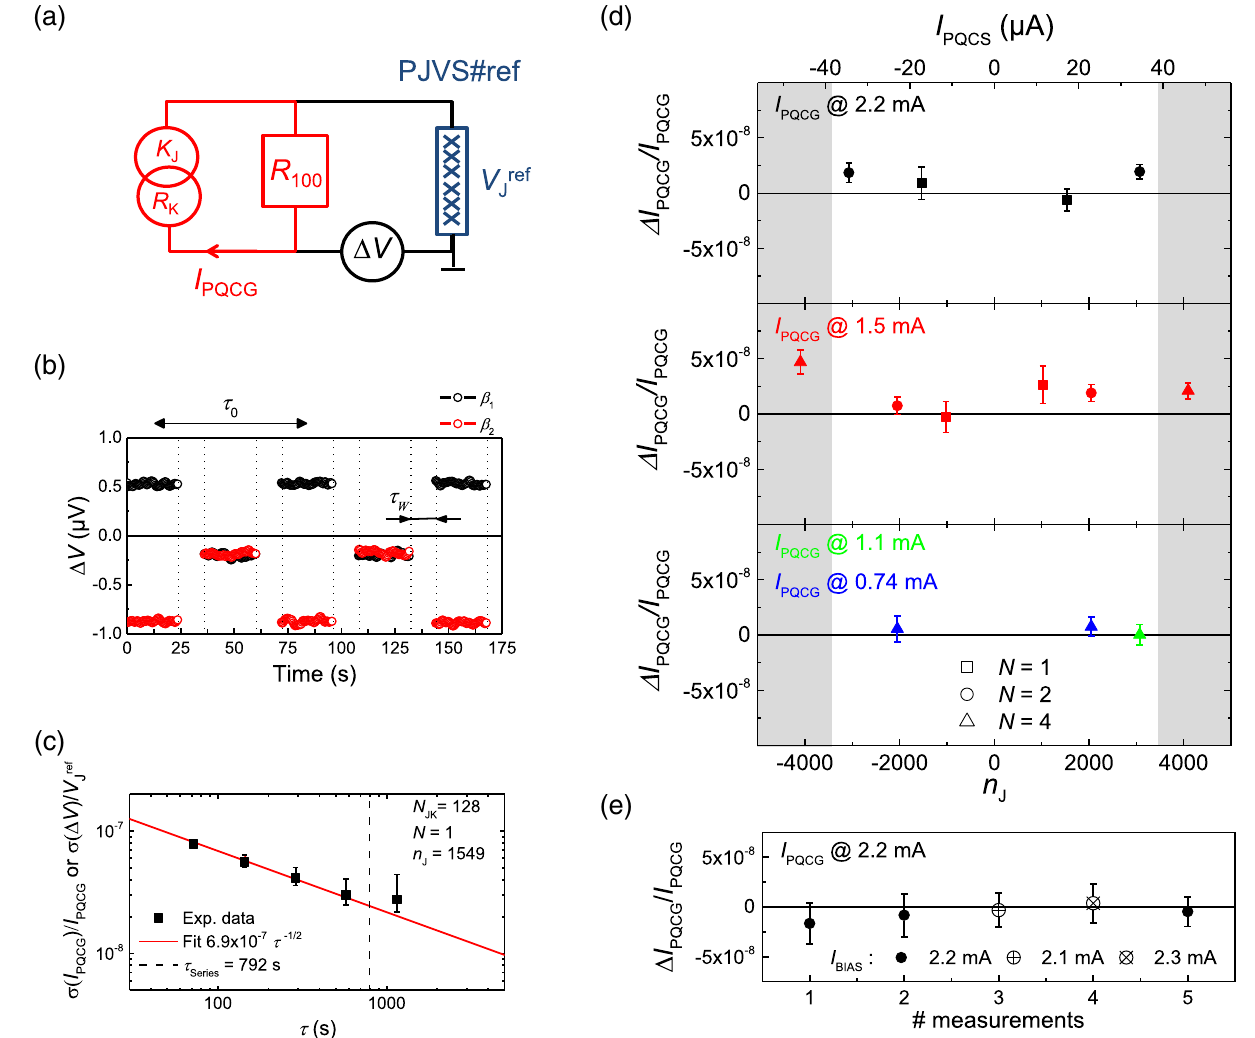
FIG. 3. Quantization tests of the PQCG. (a) Scheme of the setup for the accuracy measurements. The PQCG, symbolized by the R current source linked to the product of constants K , supplies a calibrated 100 - Ω resistor R 100 , and its voltage is compared to the J K voltage V ref of PJVS#ref using a battery-powered nanovoltmeter EM N31 (response time constant about 2 s). (b) Raw data of the voltage J null detector for two on-off-on cycles for two settings, β 1 (black dots) and β 2 (red dots), of the current divider. Note that τ 0 ¼ 72 s is the duration of one on-off-on cycle, and τ w ¼ 12 s is the waiting time before recording after the current switching. (c) Relative Allan deviation calculated from a series of 49 on-off-on cycles of I plotted as a function of time τ ð s Þ . A τ − 1 = 2 fit shows good agreement PQCG below τ ¼ 1000 s and corresponds to a relative Allan deviation of 2 . 5 × 10 − 8 for the duration of the time series used in this work, τ 792 s. (d) Δ I =I as a function of n (or I ) for several currents (both positive and negative) generated by the PQCG Series ¼ PQCG PQCG J PQCS in the mA range, using three different values for N . Error bars are combined standard uncertainties (1 s.d.). (e) Successive measurements =I 3074 , N ¼ 2 , N 129 ) for different bias currents, demonstrating the of Δ I (over four hours) obtained (with n PQCG PQCG J ¼ JK ¼ reproducibility of the current generated at 2.2 mA. Error bars are combined standard uncertainties (1